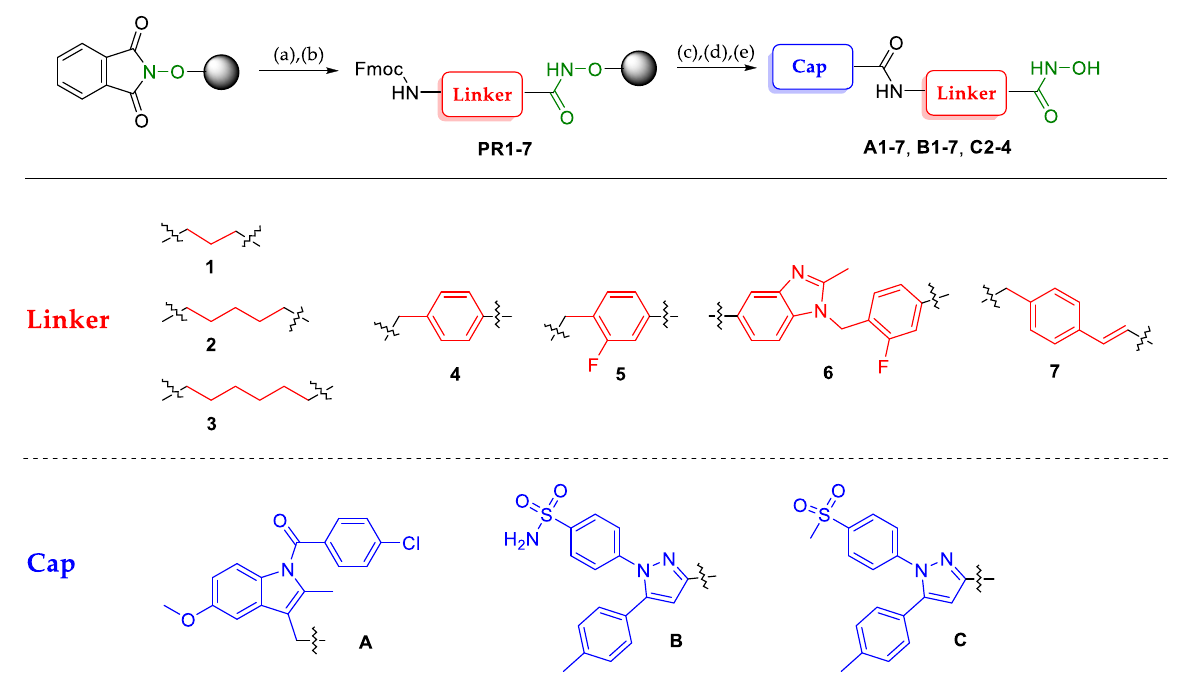
Scheme 1. Solid phase synthesis of dual HDAC-COX inhibitors. Reagents and conditions: (a) 5%